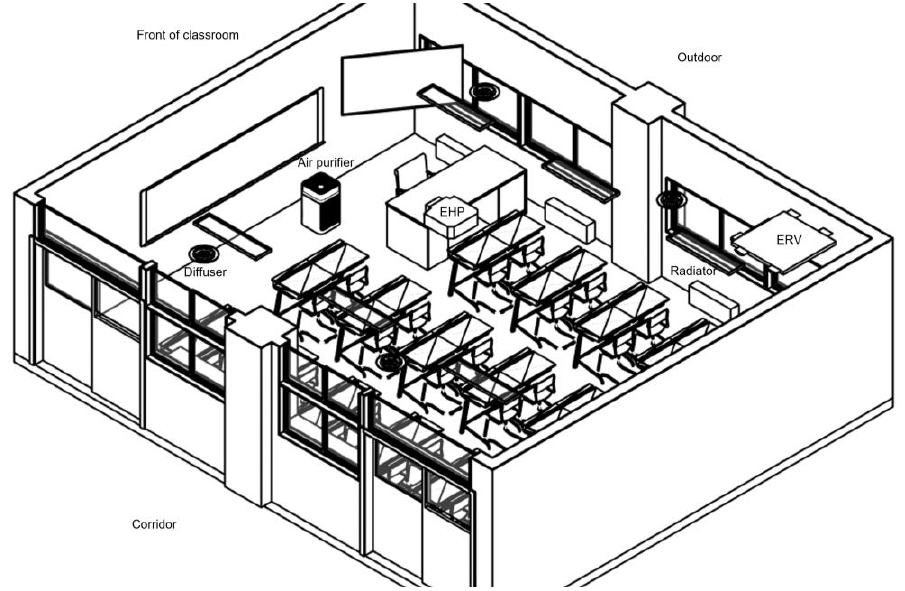
Figure 2. Typical primary and secondary classroom in South Korea.